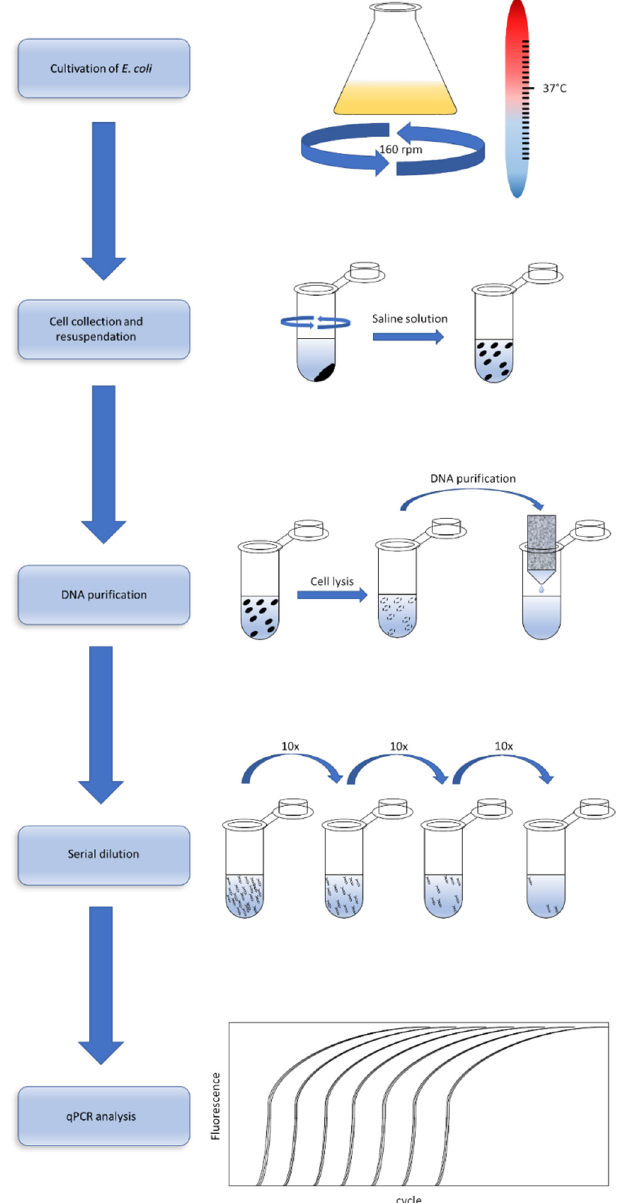
Figure 4. Workflow of the laboratory exercises. Cultures were grown on 37 °C in an orbital shaker incubator. Cells were collected by centrifugation, then resuspended in saline solution. The cell suspension was treated with the QiaAmp ® DNA Mini kit’s lysis solution, then the cell lysates were loaded to the QIAamp ® Mini Spin Columns. After washing and elution, serial dilutions were made from the DNA samples by the factor of 10. The dilution series were utilized in the qPCR reactions.